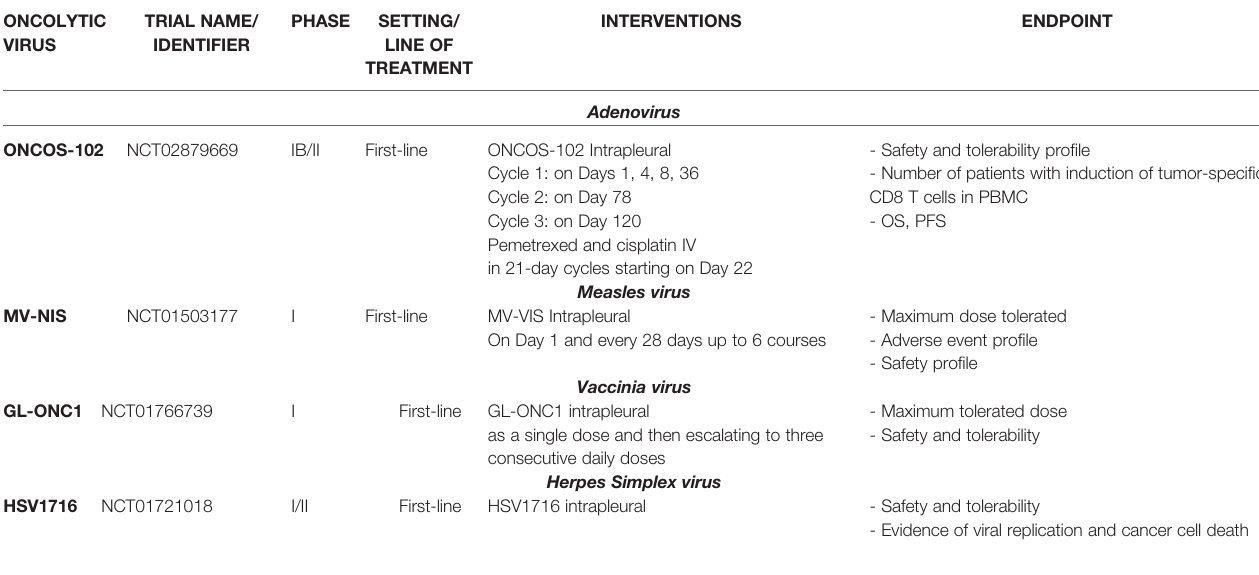
TABLE 2 | Clinical trials employing oncolytic viruses. ONCOLYTIC